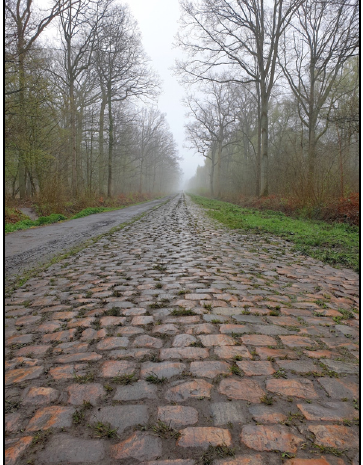
Figure 34. Pavè track.